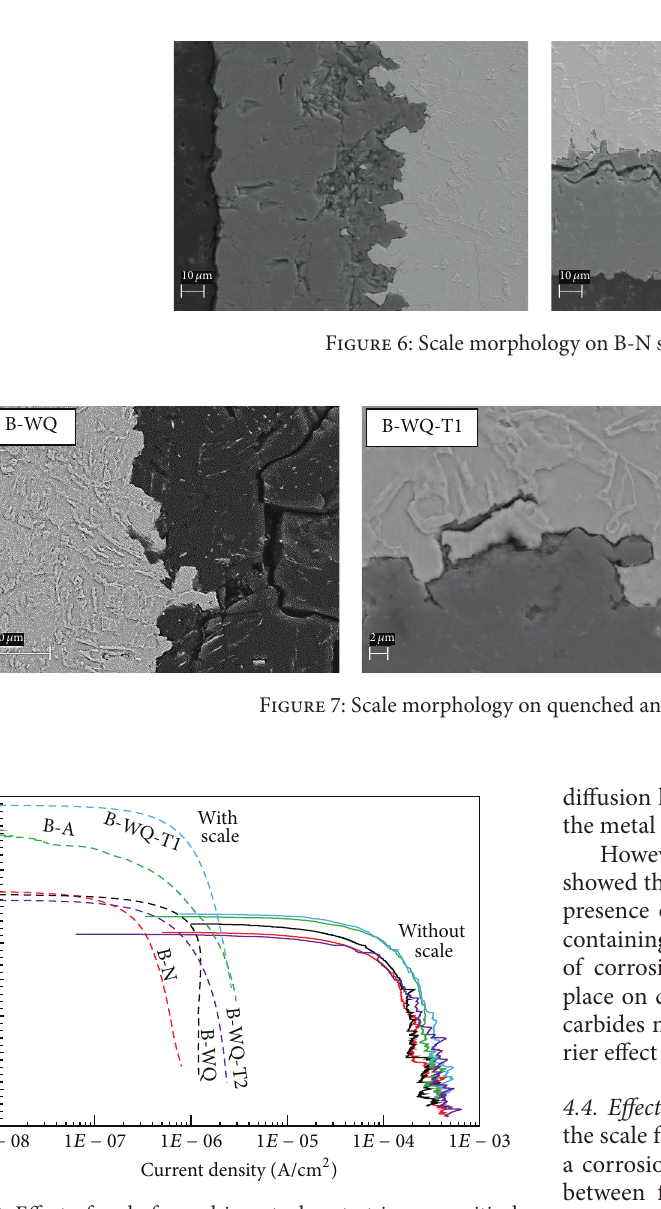
Figure 8: Effect of scale formed in autoclave test in supercritical CO 2 on cathodic potentiodynamic curve in sulphuric acid solution at pH